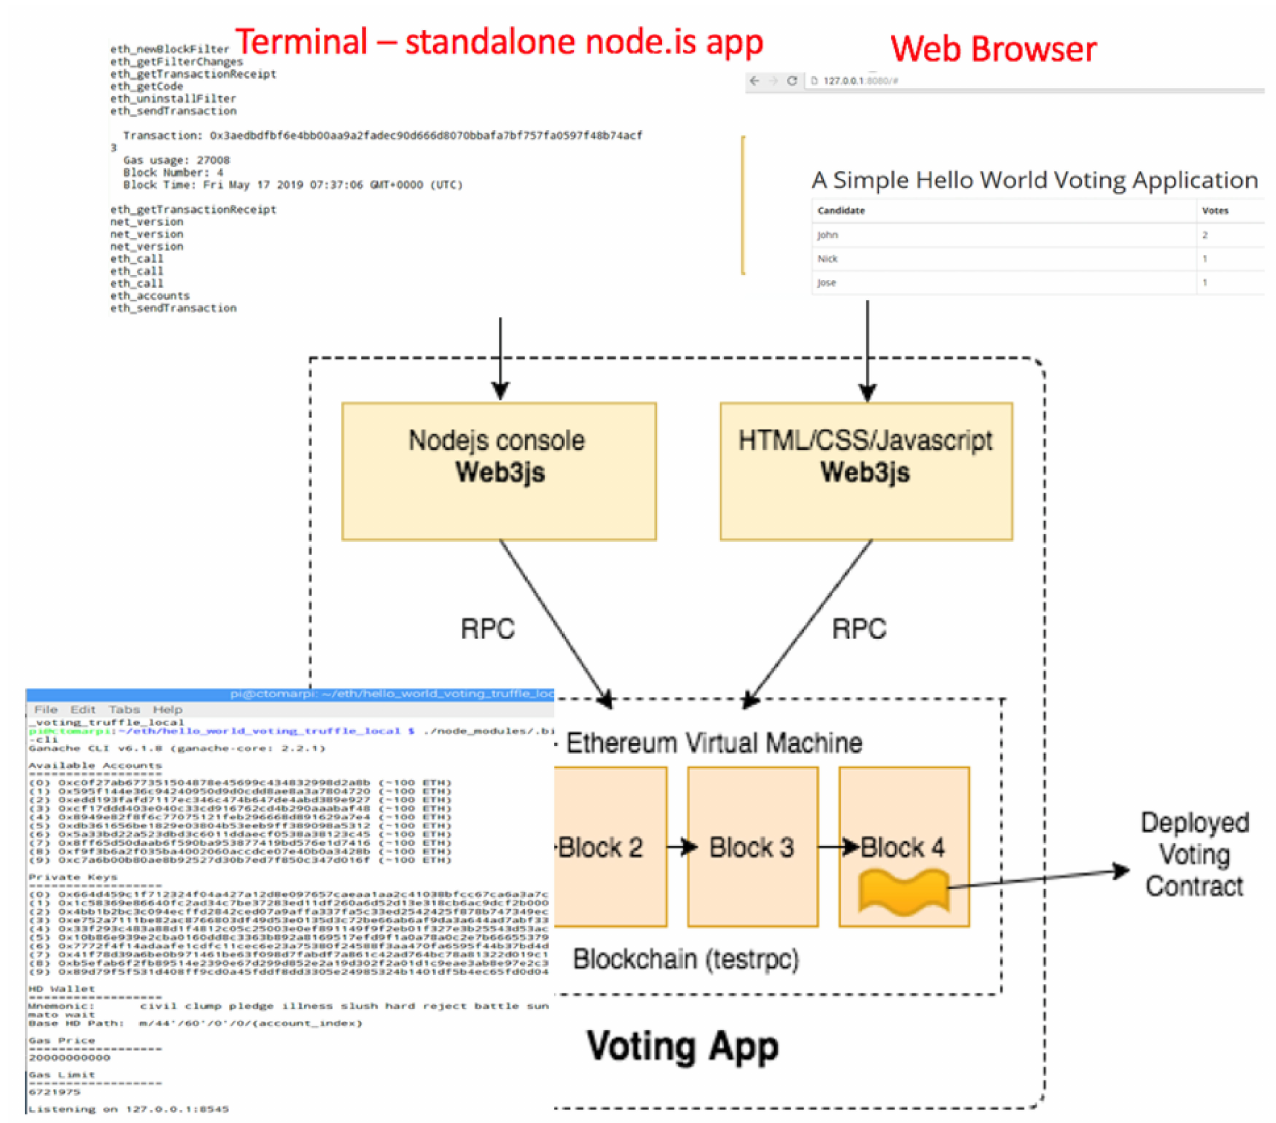
Figure 16. The web interface for displaying the votes number available for access on each IoTeD node of the e-voting D-App